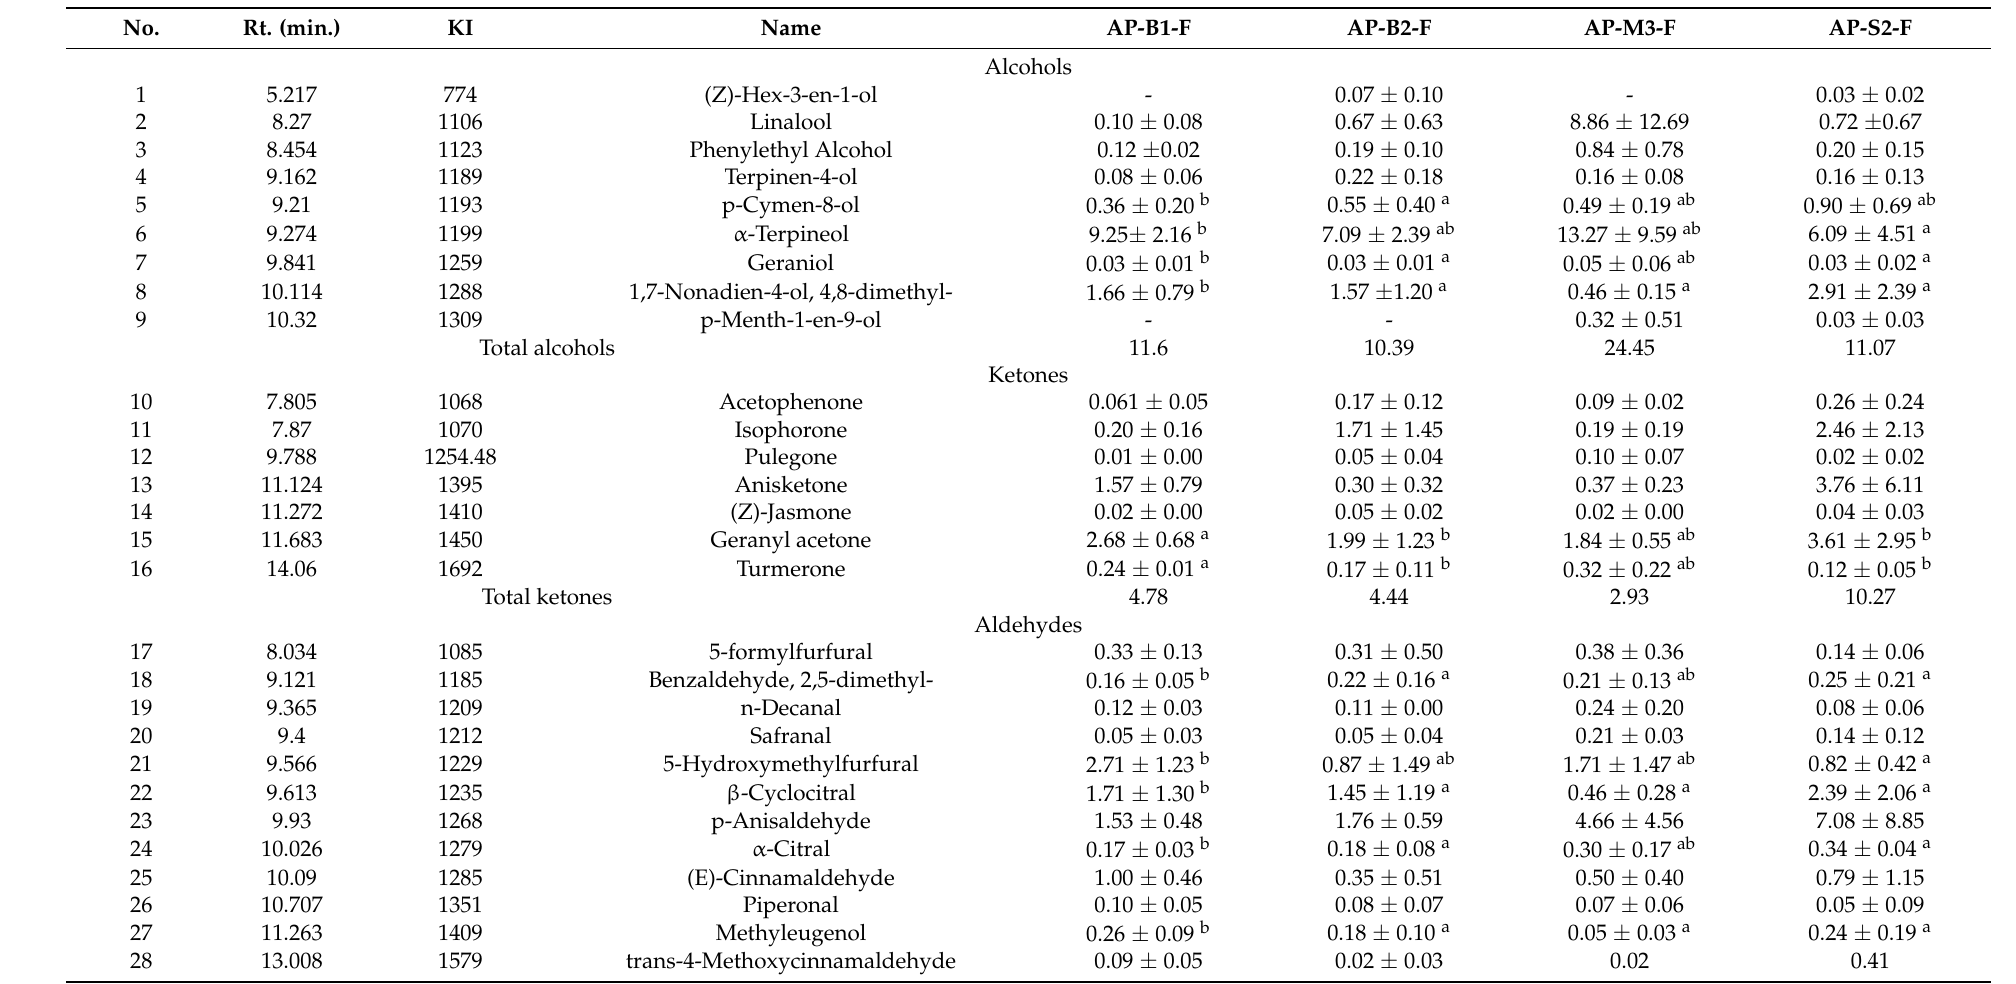
Table 3. Relative percentage of volatile metabolites in apricot fruits analyzed via GC–MS, n = 3. For codes, refer to Table 1. Results are average of 3 independent replicates ± std. deviation. a,b Different letters in the same line concerning P. armeniaca L. specimens indicate significantly different values ( p < 0.05; Tukey’s